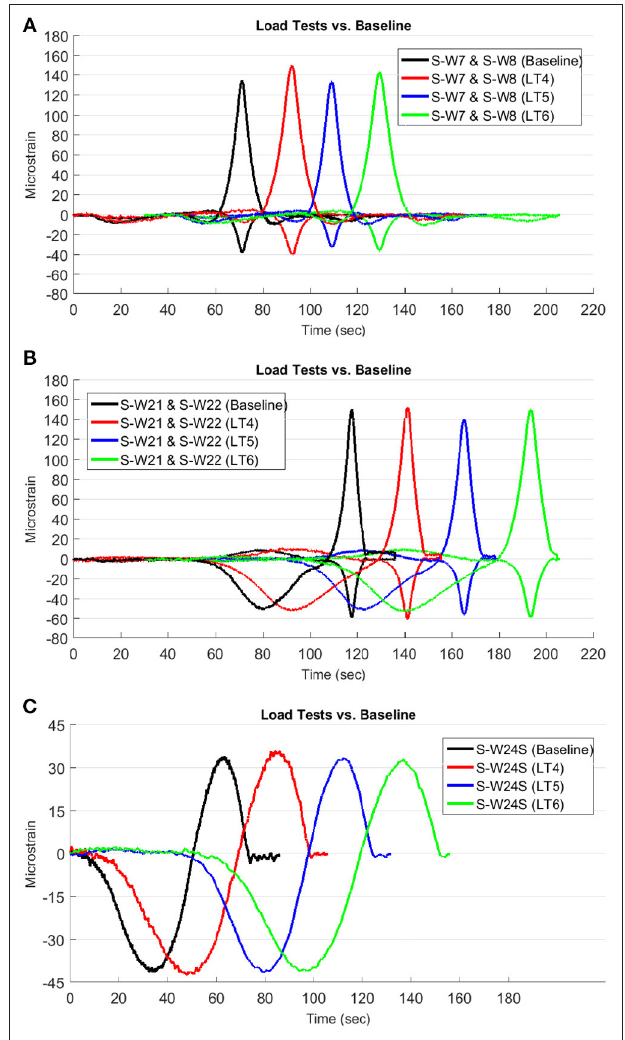
FIGURE 5 | Baseline strain time histories compared to time histories from load tests 4, 5, and 6 for six truck pass: (A) west girder midspan; (B) west girder controlling location; (C) pylon.